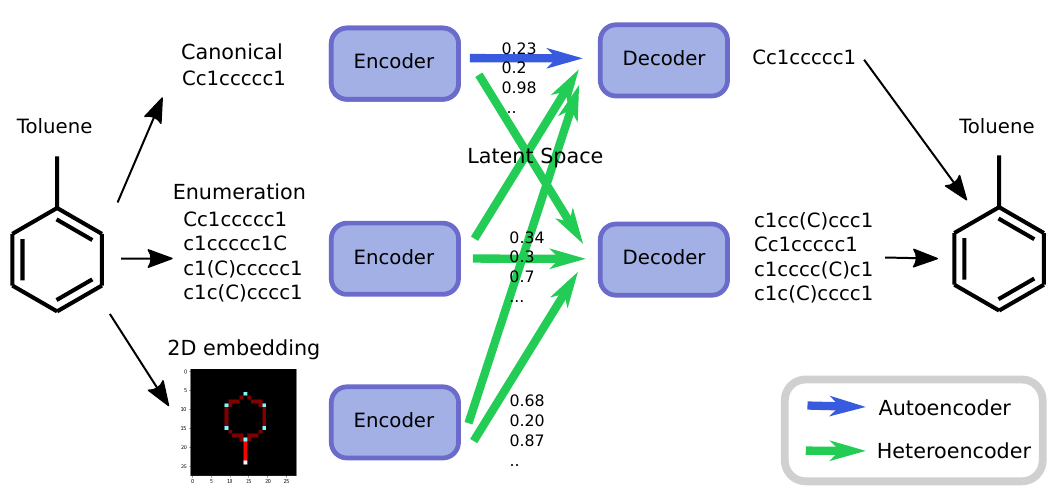
Figure 2. Chemical heteroencoders are similar to autoencoders but translates from one representation of the molecule to the other. The molecule toluene can be represented as a canonical SMILES strings, in different enumerated SMILES or via a 2D embedding. The autoencoder converts the canonical SMILES string to the latent space and back again (blue arrow), whereas many more possibilities exists for heteroencoders (green arrows).